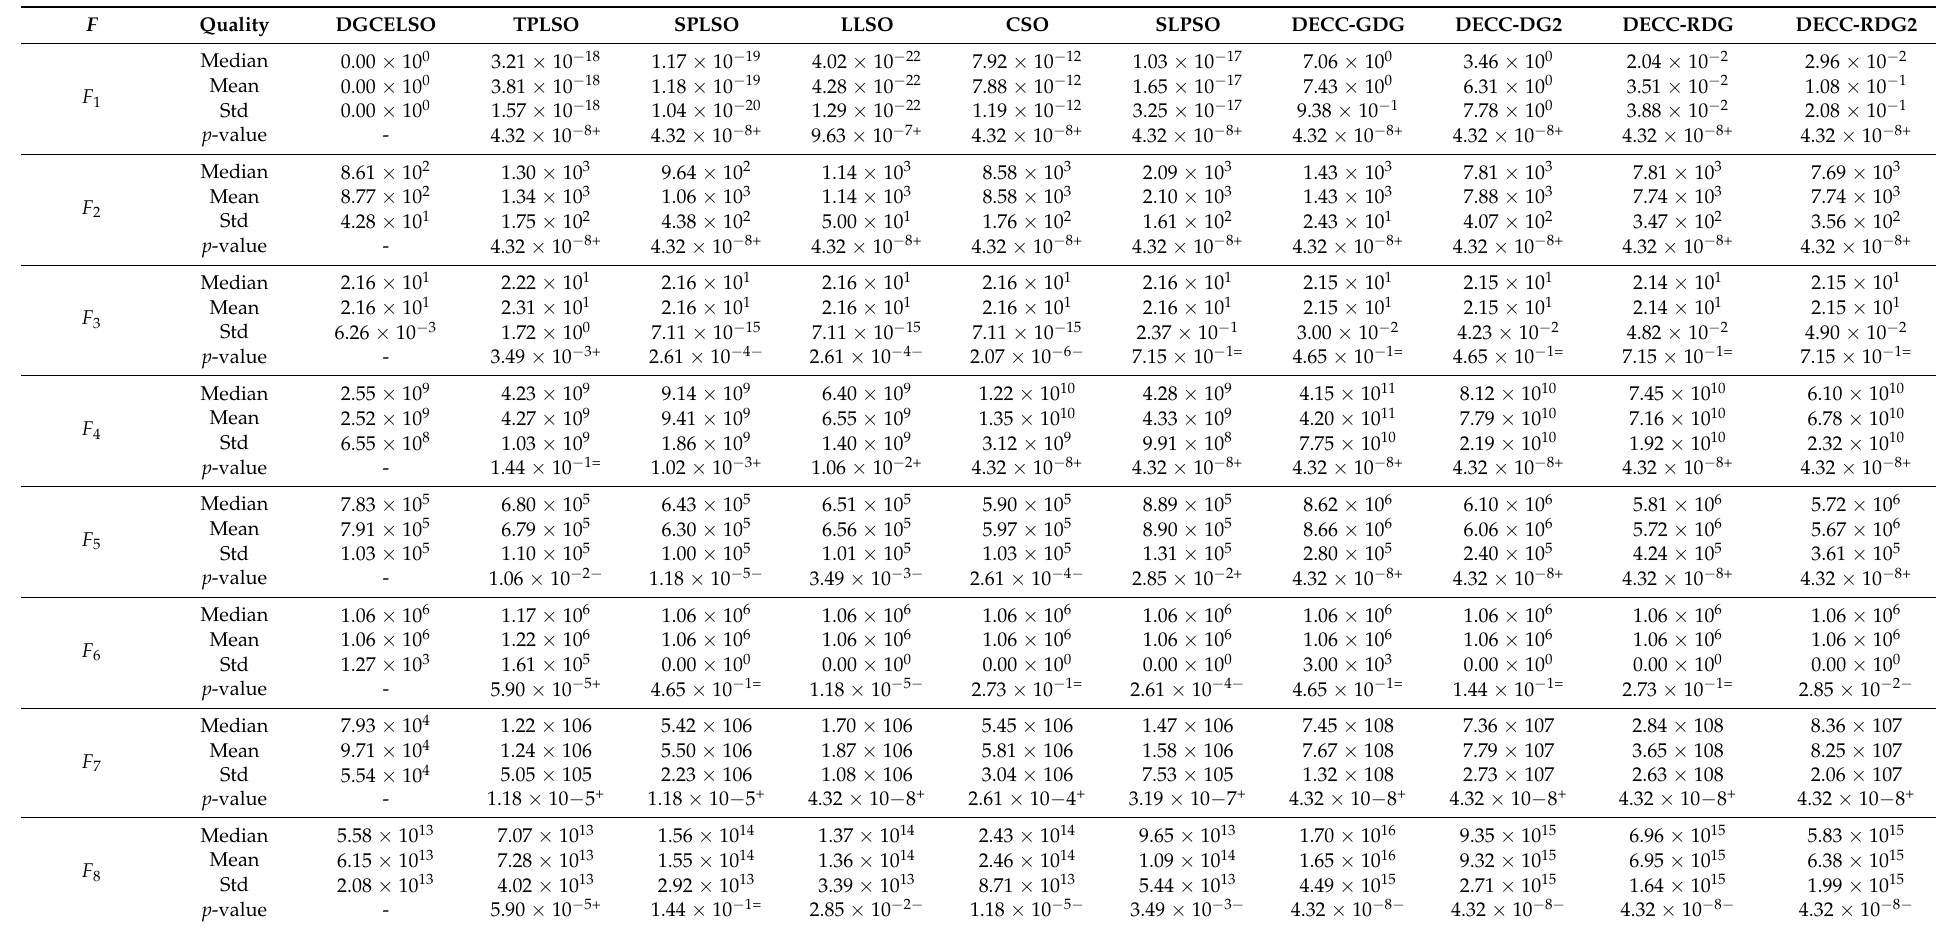
Table 3. Fitness comparison between DECELSO and the compared algorithms on the 1000-D CEC’2013 problems with 3 × 10 6 fitness